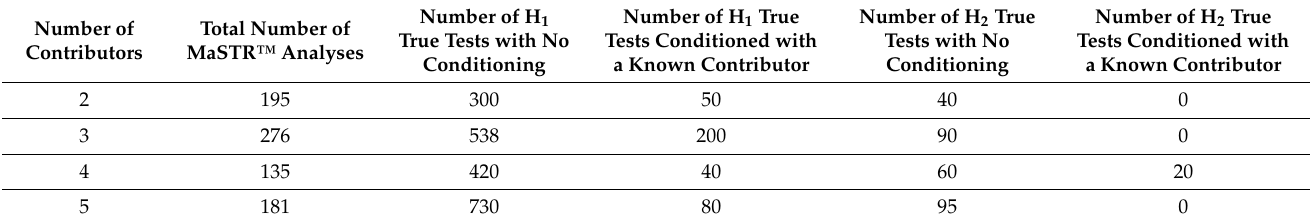
Table 4. Summary of the number of analyses and specific condition tests for each mixture type performed with the MaSTR™ software. The total number of tests was determined by multiplying the number of analyses for a given mixture type by the number of contributors, i.e., each two-person mixture analysis will yield two LRs, each three-person mixture will yield three LRs, etc. Conditioned tests had at least one true contributor defined as a known. The totals shown here are only for tests performed using the correct number of contributors